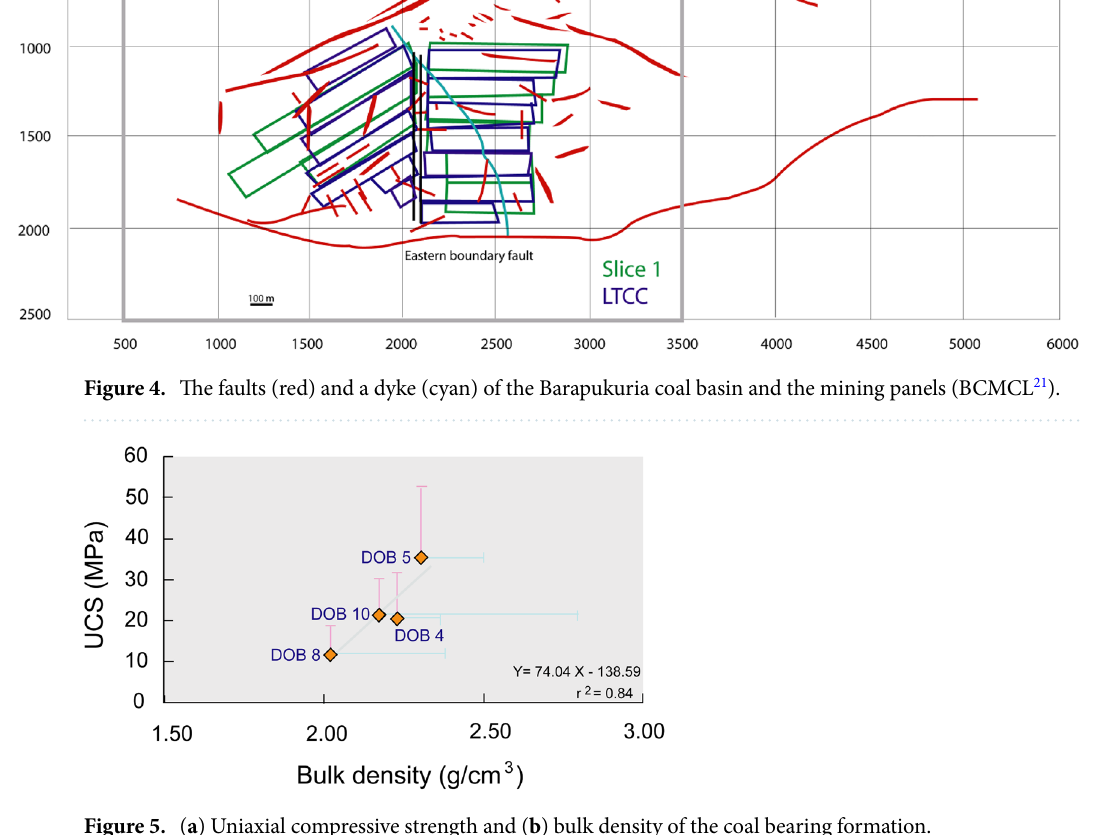
Figure 5. ( a ) Uniaxial compressive strength and ( b ) bulk density of the coal bearing